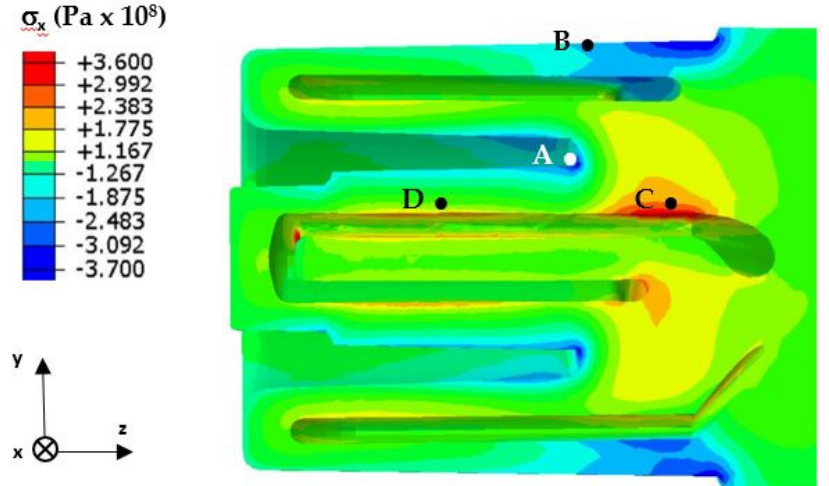
Figure 10. The stress σ x in the y–z section of the core at 0.7 s after metal injection into the